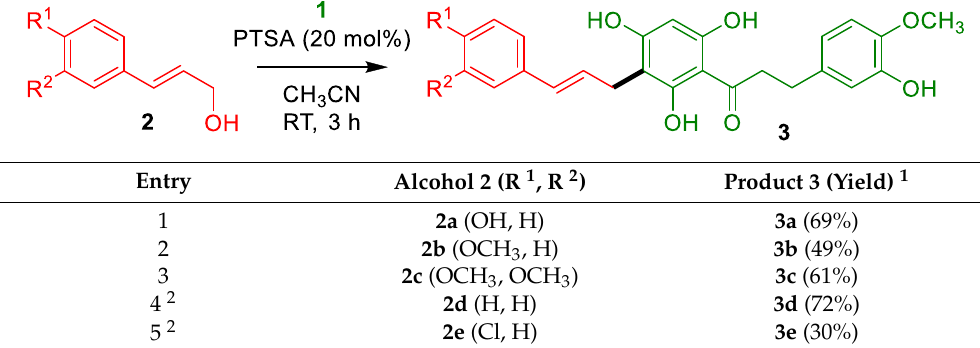
Table 1. Catalytic Cinnamylation of Dihydrochalcone 1 .